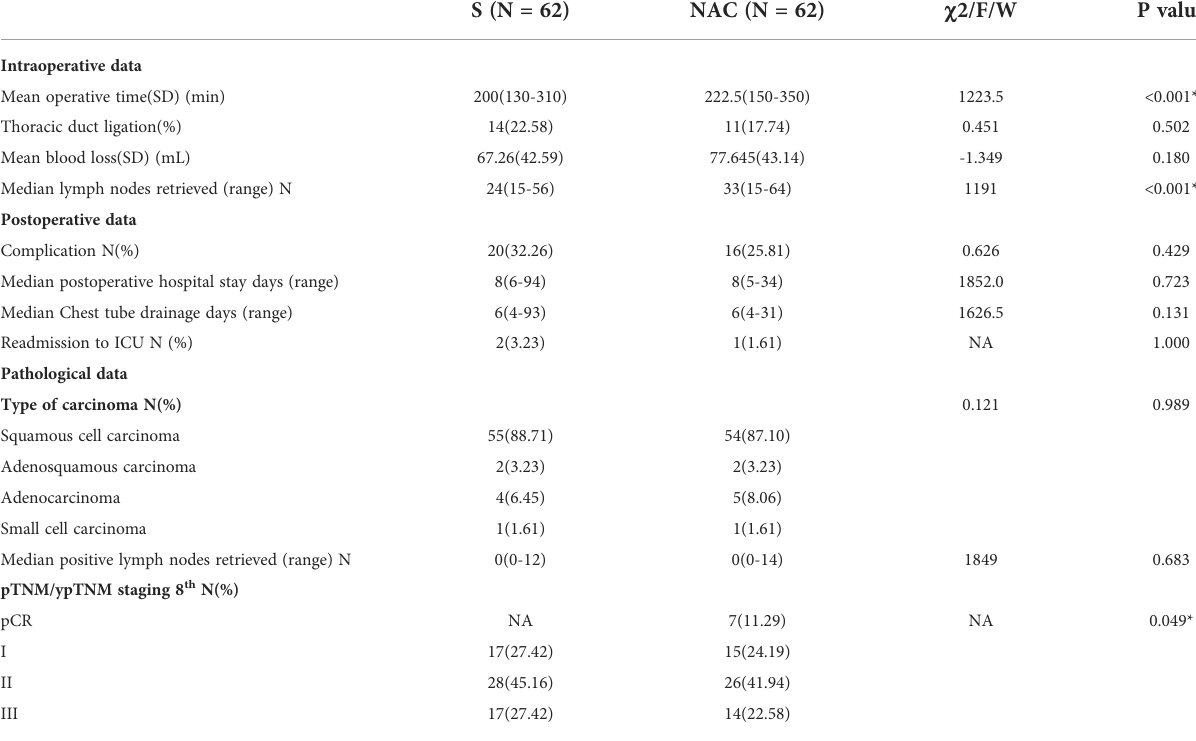
TABLE 2 Intraoperative and Postoperative Outcome.